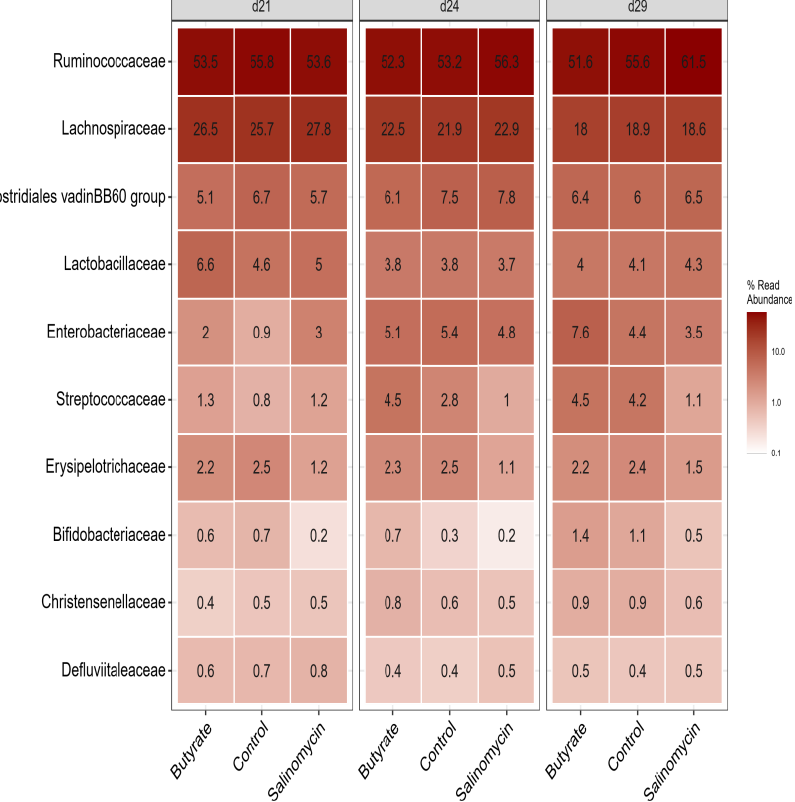
Figure 6. Heatmap showing the relative abundance of the top 10 most abundant microbiota at the family level across all ceca samples (irrespective of treatment or age) and visualized for each age and treatment group, separately. The samples were collected on days 21, 24, and 29 of age from chickens administered butyrate (UltraGuard™-DUO, 500 mg/kg), salinomycin (Sacox ® , 69 mg/kg), or no dietary supplement